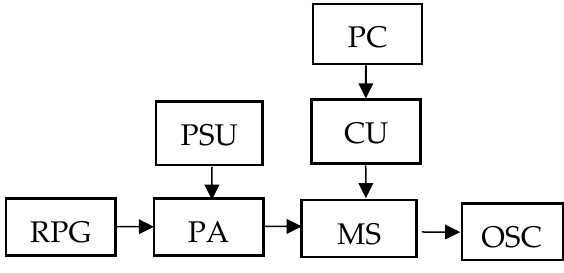
Figure 6. The block diagram of the experimental setup.